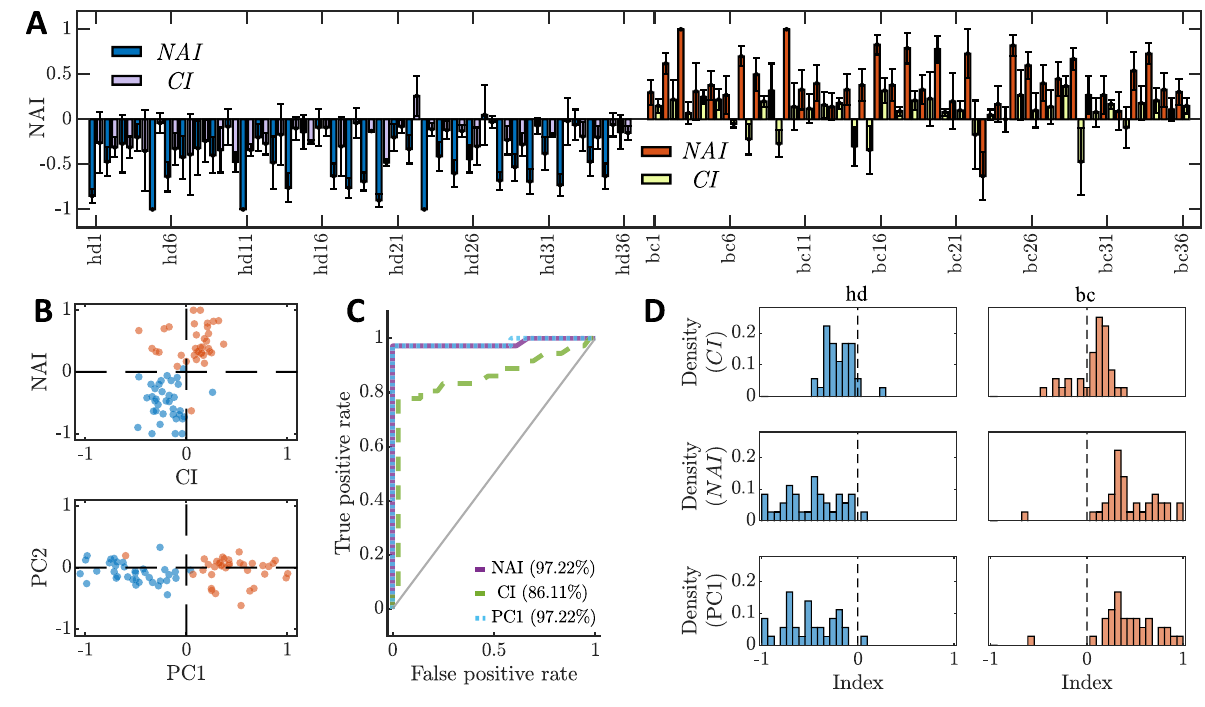
Figure 5. Comparison between the CI and the NAI. ( A ) Bar plot of the resulting NAI and CI values for each sample of the control (blue bars) and positive group (red bars) reported with the corresponding standard deviation calculated assuming a binomial distribution of the variables. Although both indexes show a clear tendency (positive values for cancer samples, negative values for the control group), the accuracy and the contrast associated with the NAI is considerably higher if compared to the CI. ( B ) The top graph reports the scatter plot in the original space of NAI vs CI for the averaged values obtained over replicate samples of each subject (patients in red and healthy donors in blue). The bottom graph reports the first two principal components (PC1, PC2) of the Principal Component Analysis (PCA) obtained for the data reported in the top graph. The outcome of the analysis shows that PC1 explains 90.95 % of the total variance with NAIs contributing to most of the separation between the points of the two groups (representing a loading coefficient for PC1 of 97.31 % ). ( C ) ROC curves obtained for the CI, for NAI, and the first component of the principal component analysis. It is clear from the graphs that the calcium imaging measurements yield a better discrimination between the positive group and the control one. The first component of the PCA improves the discrimination power of the NAI, although it does not differ from it too much. ( D ) Distributions of the measured CI, NAI, and PC1 (from top to bottom), for both the control group and patients (left and right graphs respectively for each row).